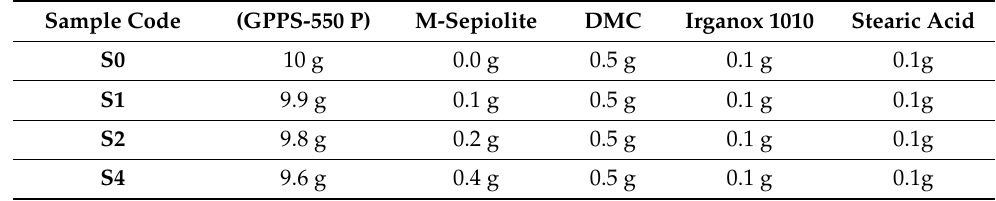
Table 2. Formulation details of